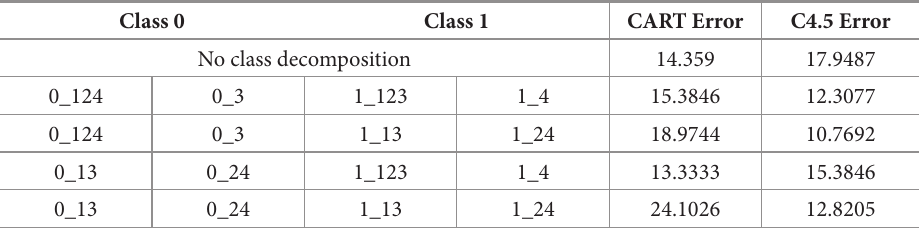
Table 8. Classification errors of decomposed classes transformed for existing